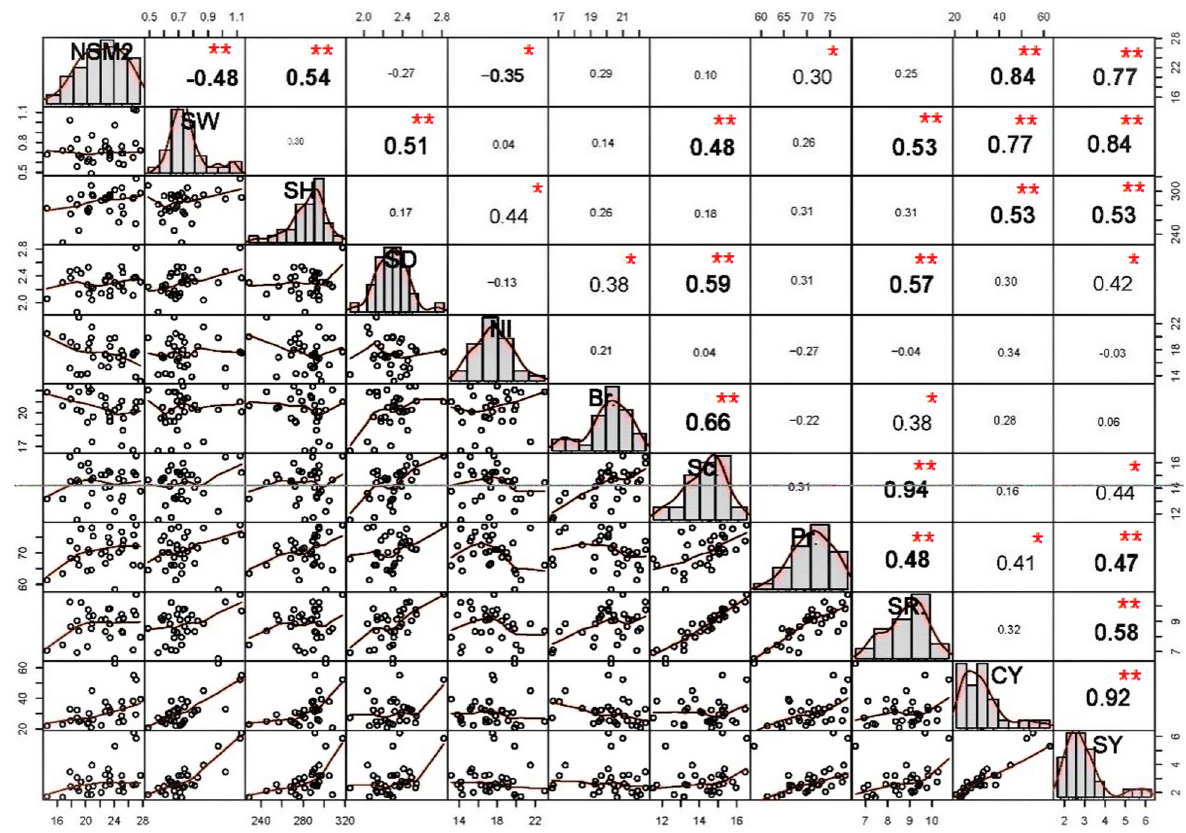
Fig. 1 Correlation matrix among SY, sugar yield (ton/fed); CY, cane yield (ton/fed); NSm − 2 , number of stalk m − 2 ; SW, stalk weight; SH, stalk height/ cm; SD, stalk diameter/cm; NI, number of internodes; Br, Brix %; Sc, sucrose %, Pr, purity %; and SR, sugar recovery